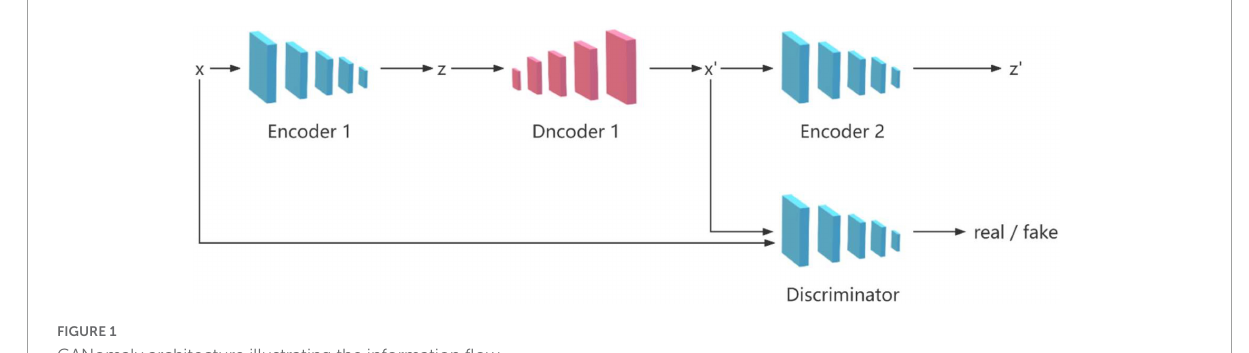
FIGURE1 GANomaly architecture illustrating the information flow.